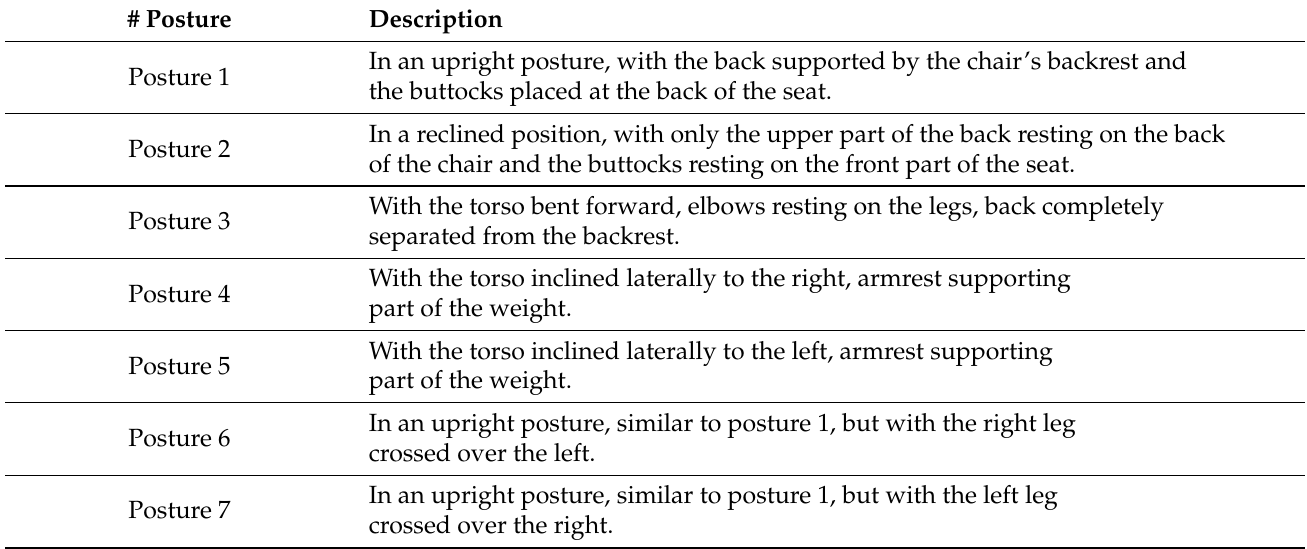
Table 1. List of recorded